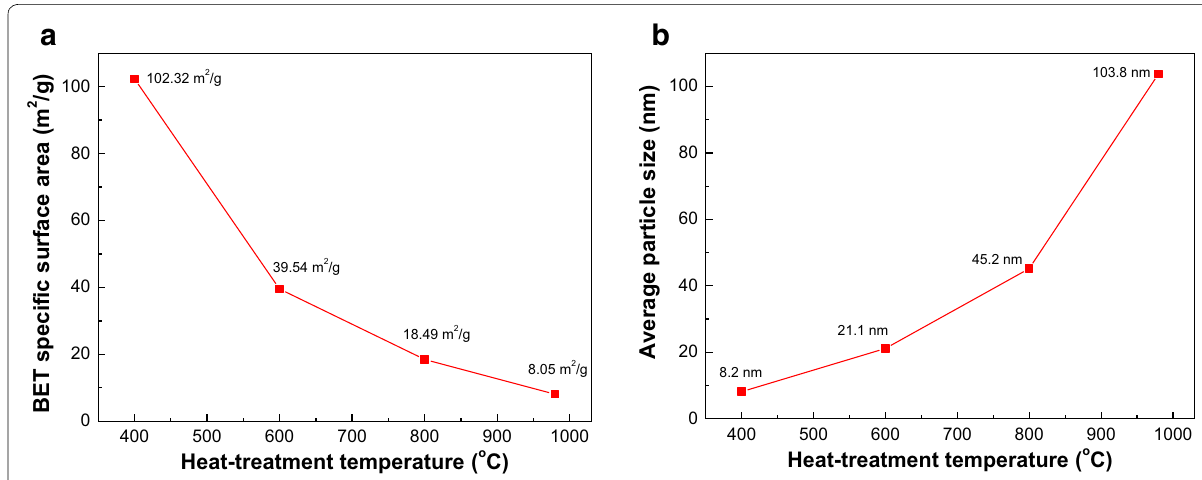
Fig. 1 a BET SSA and b average particle size of ITO‑NPs dependent on heat‑treatment